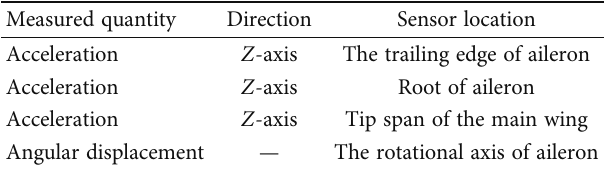
Figure 16: Locations of accelerometers in the wind tunnel fl utter test. Table 5: De fi nition and location of measure sensors during the wind tunnel fl utter